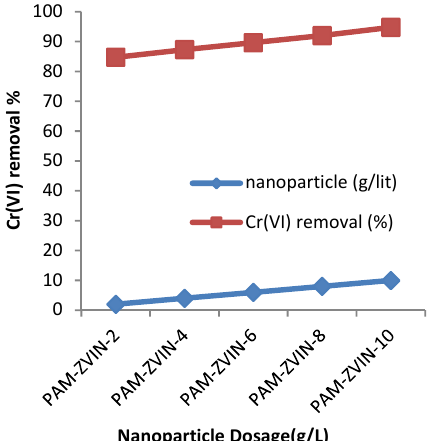
Fig.4.The removal efficiency of Cr(VI) using PAM- ZVINs as a function of PAM- ZVINs dosage